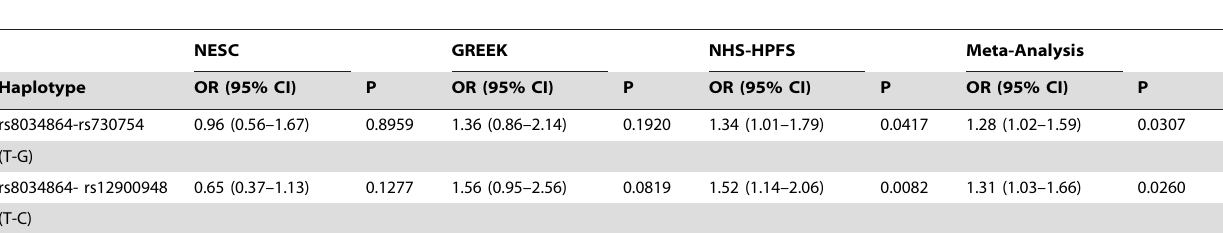
Table 5. Significant haplotypes in RORA for wet AMD in the NESC, GREEK, NHS-HPFS cohorts, and in meta-analysis using an additive model.